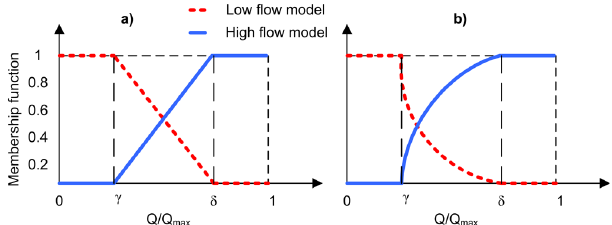
Fig. 2. (a) A typical fuzzy membership function used to combine the single specialized models (MFtype A), (b) a class of member- ship functions for high and low-flow models tested in the new ex- periments (MFtype